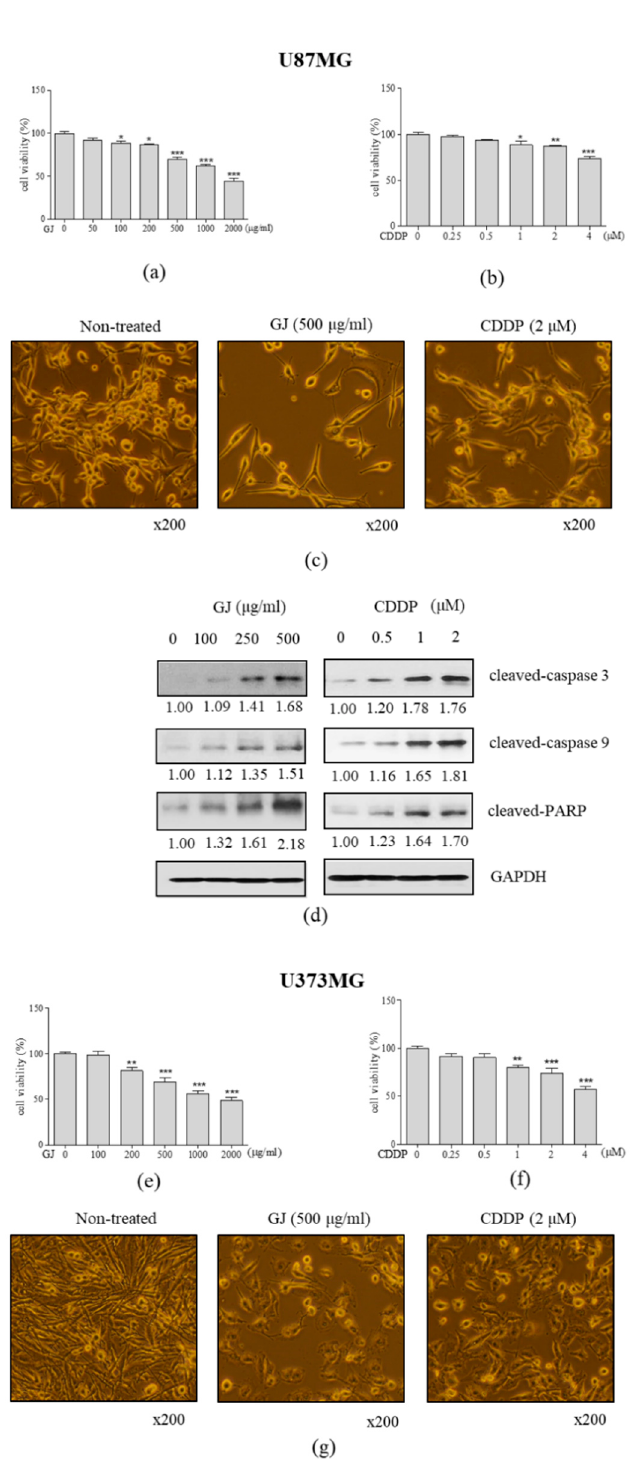
Figure 1. E ff ect of GJ and CDDP on cell viability of U87MG and U373MG cells. MTT assays were performed in ( a ) GJ-treated and ( b ) CDDP-treated U87MG cells. ( c ) Microscopical observation of cell morphology was performed in GJ- and CDDP-treated U87MG cells. ( d ) Western blot assays on cleaved caspase-3, cleaved caspase-9, and cleaved poly (ADP-ribose) polymerase (PARP) were performed in GJ- and CDDP-treated U87MG cells. MTT assays were performed in ( e ) GJ-treated and ( f ) CDDP-treated U373MG cells. ( g ) Microscopical observation of cell morphology was performed in GJ- and CDDP-treated U373MG cells. Results are displayed as mean ± S.E. of three or more separate experiments. Glyceraldehyde-3-phosphate dehydrogenase (GAPDH) was used as endogenous control. * p < 0.05 vs. untreated cells, ** p < 0.01 vs. untreated cells, *** p < 0.005 vs. untreated cells. GJ, Gardenia jasminoides ; CDDP, cisplatin.